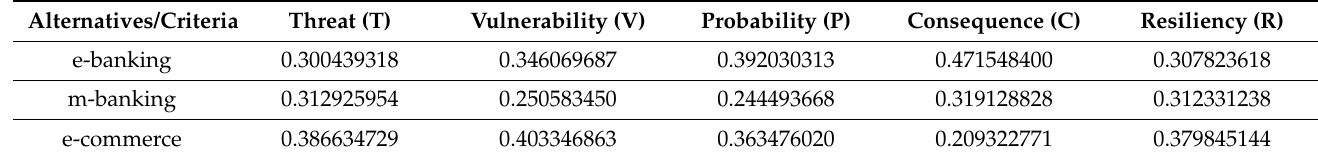
Table 10. Eigenvectors of generic ISRA criteria for transaction systems.